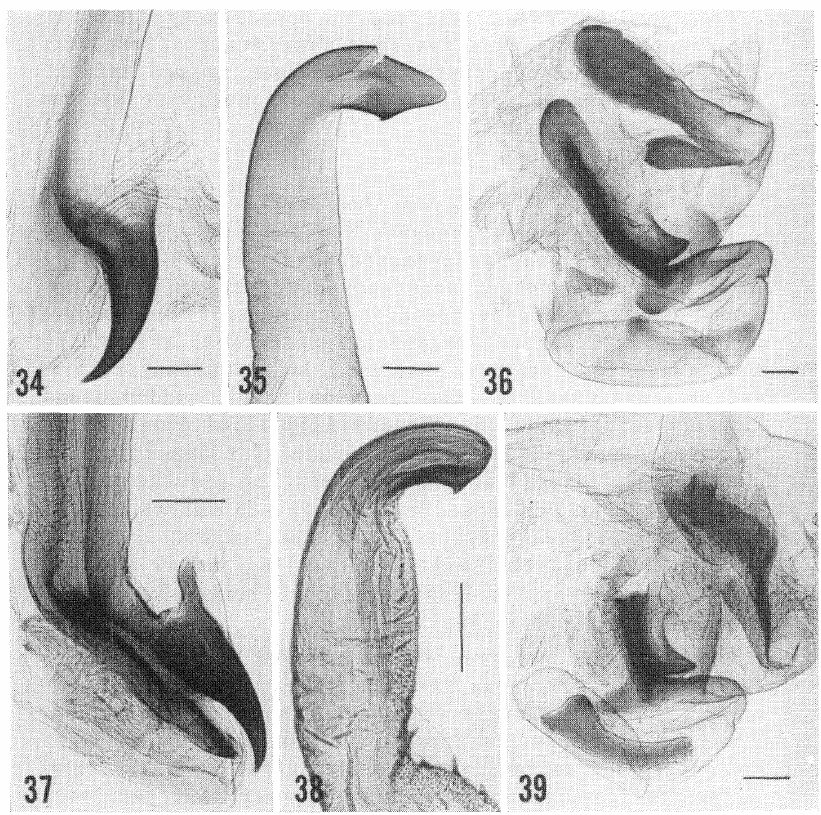
Figs. 34-39. Poeciloderrhis spp. 34-36. (9, BMNH). P. atri,’entris; tergzl glands in Figs. 43-44. (det. Hebard). 37-39. (183, USNM). P. catharina. (Type of /ludreia catharina Shelford. St. Catharina, Brazil; adul in Figs. 41-42.) (scale 0.2